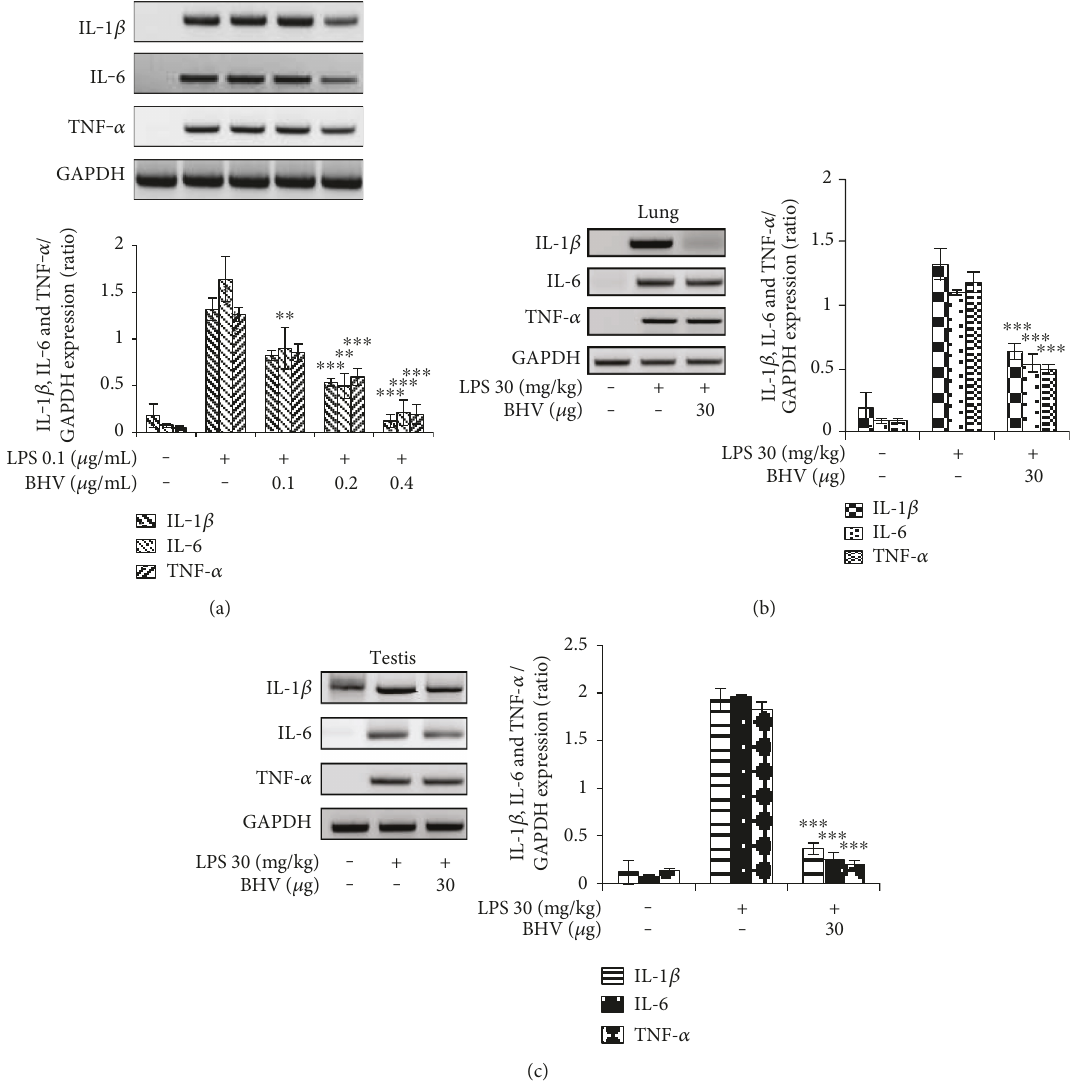
Figure 3: B. hebetor venom diminished mRNA expressions of IL-1 β , IL-6, and TNF- α under LPS stimulation. For mRNA expression, RAW 264.7 cells were pretreated with BHV (0.1 μ g/mL – 0.4 μ g/mL) for 30min and then stimulated with LPS (0.1 μ g/mL) for 18hr. Total RNA from cell, lung, and testis tissue was isolated by TRIzol RNA extraction reagent, and mRNA expression of IL-1 β , IL-6, and TNF- α was determined by RT-PCR. GAPDH was used as the housekeeping gene. Images are representative of 3 independent experiments. Cytokines expression in cells (a). Cytokines expression in lungs (b). Cytokines expression in testis (c). Values in bar graph are mean ± SEM of 4 independent experiments. ∗∗∗ p < 0 001 and ∗∗ p < 0 005 compared to LPS